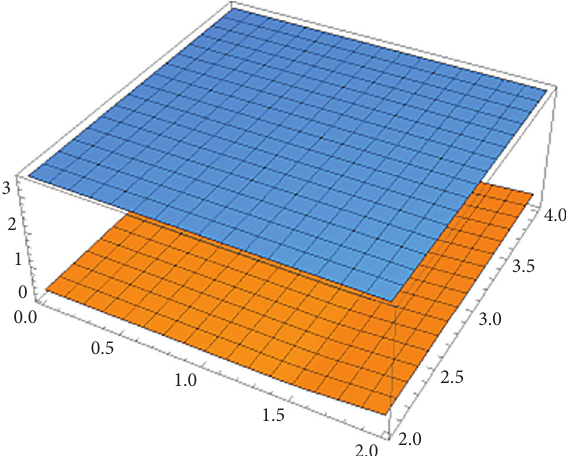
Figure 2: Dominance of right-hand side of equation (28) is visually checked for τ ∈ [ 0 , 2 ] , υ ∈ [ 2 , 4 ] .